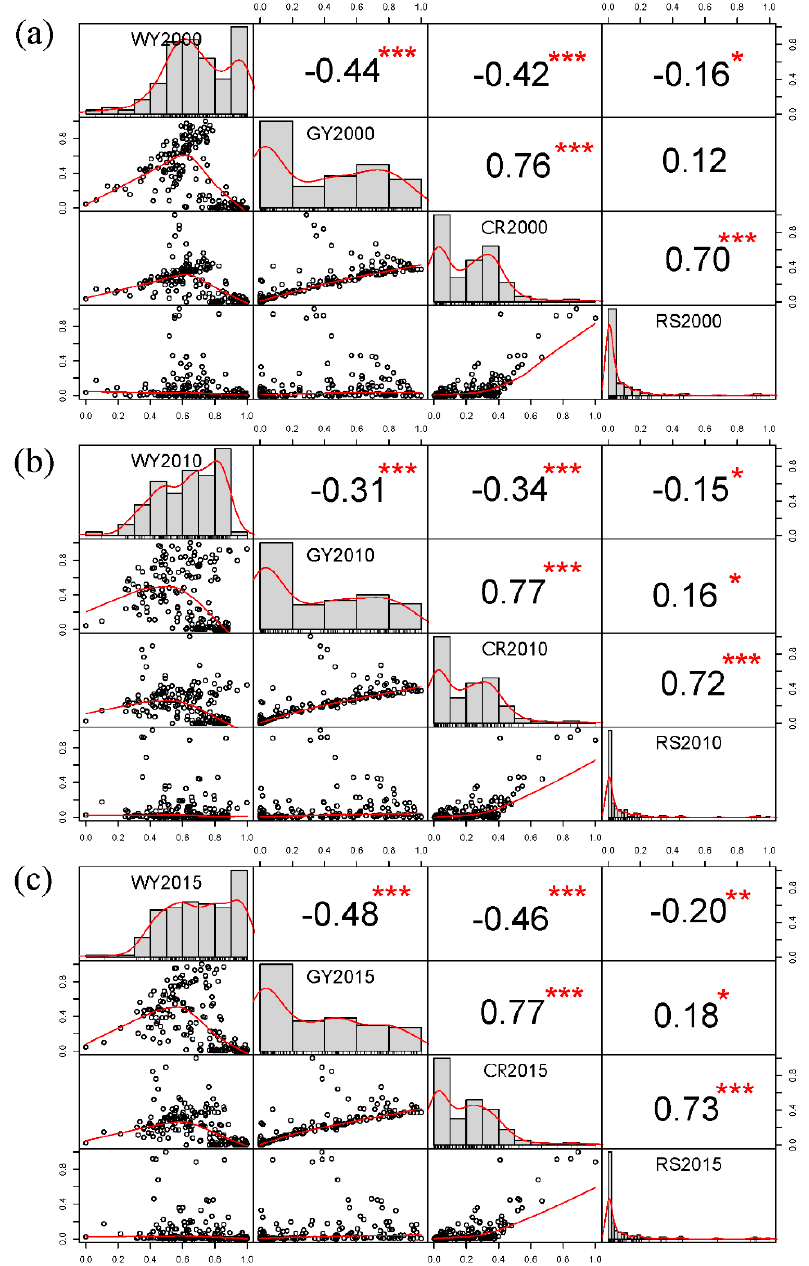
Figure 9. Matrix of Pearson’s correlation coefficients between the four ES in 2000 ( a ), 2010 ( b ), and 2015 ( c ). * p < 0.1; ** p < 0.05; and *** p < 0.01.